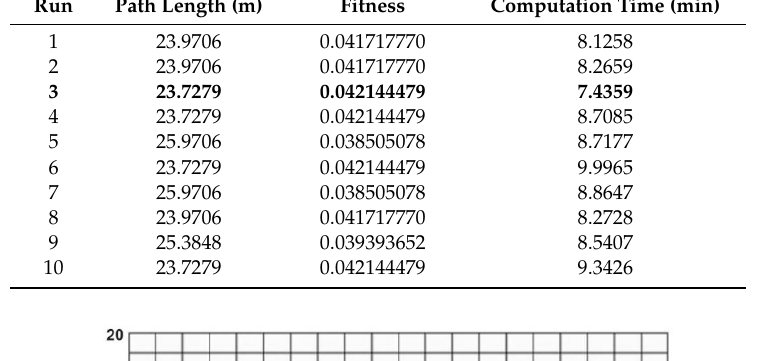
Table 6. Simulation results for the grid-based dynamic environment 2 using the ABACO algorithm.